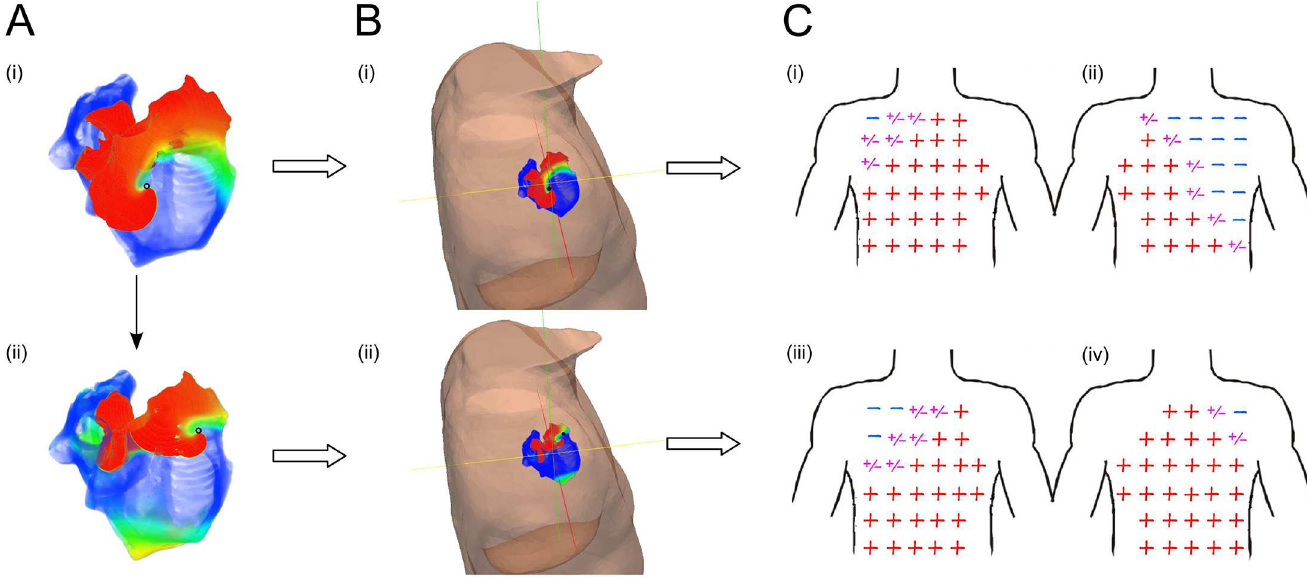
Fig 7. Comparison of quadrants position and atrial-waves polarity maps in meandering re-entrant activation. (A) Snapshot at two different instant of re-entrant activationin the atria. (B) Snapshot at two different instant of re-entrant activationof the atria-torso model from a posterior superior right view. (C) Simulated64-leadECG atrial-wavespolarity map at two different instant of re-entrant activation. We observedthe polarity pattern of the atrial waves of the experimental and simulation, in the anterior (i), (iii) and posterior (ii), (iv) part of the body. The red positive sign represents a positive atrial-wave,the blue negative sign represents negativeatrial-wave, and the purplepositive/negative sign represents a biphasicatrial-wave.